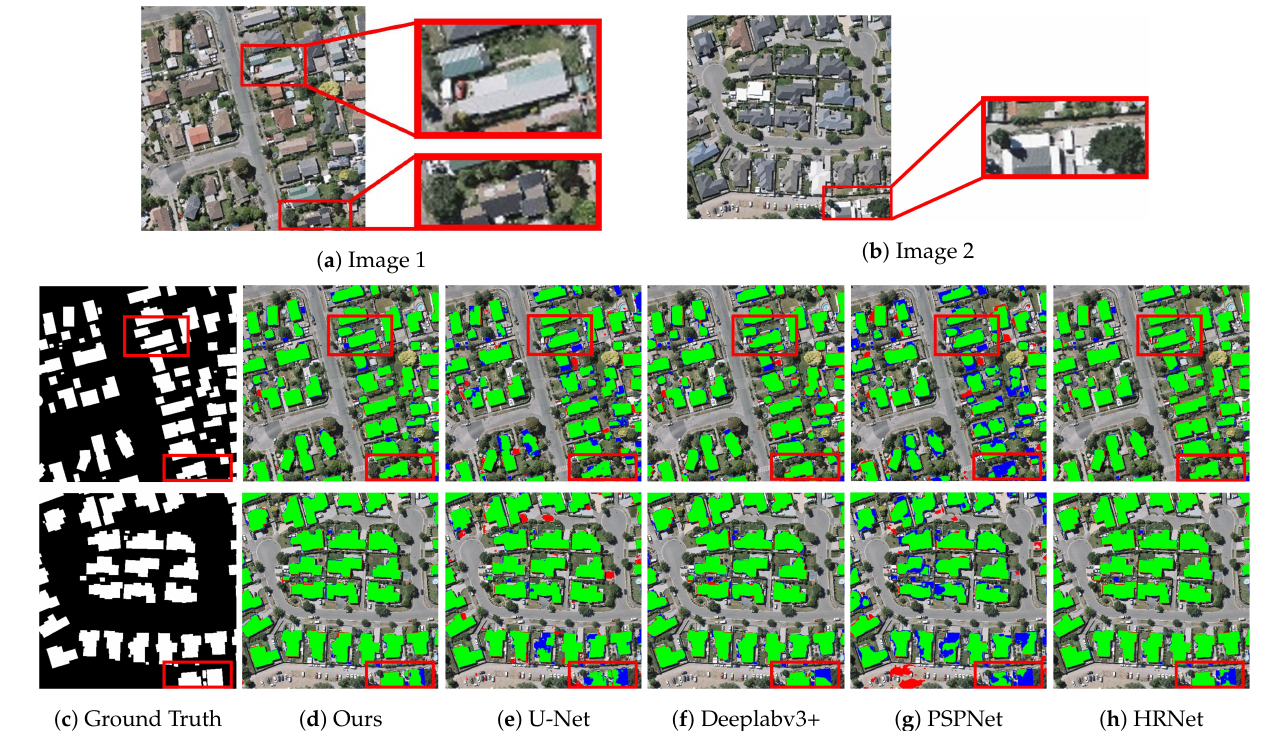
Figure 5. Results of different methods on buildings of small size and complex shapes. ( a , b ) are the original images; ( c ) ground truth; ( d ) the results of CFENet; ( e – h ) show the results of U-Net, Deeplabv3+, PSPNet and HRNet, respectively. Green, red, and blue pixels on the map represent predictions of true positives, false positives, and false negatives, respectively. The experimental results in the red box show the areas where the contrast effect is more obvious.